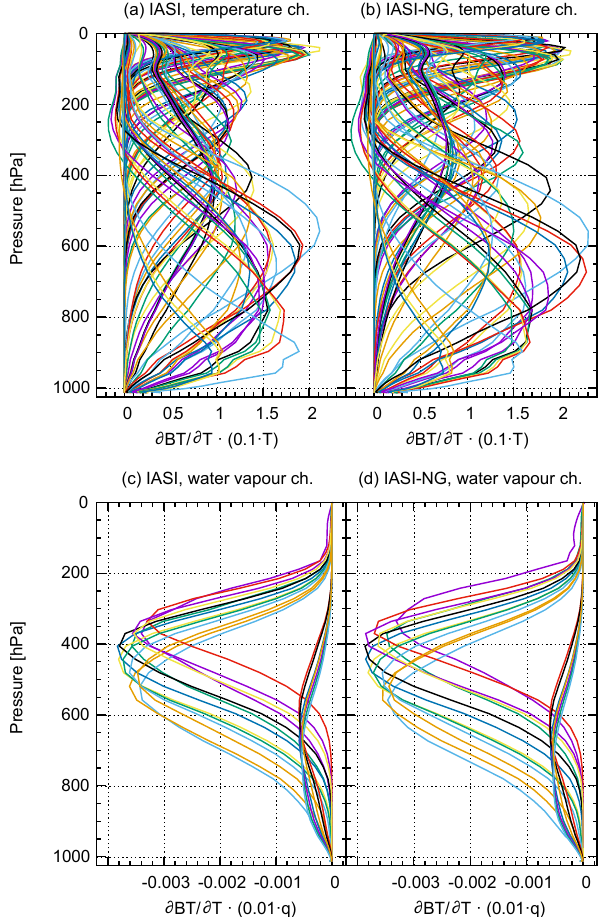
Figure 8. Temperature (a, b) and humidity (c, d) averaged Jaco- bians from the considered 1681 simulations computed for the 123 IASI (a, c) and IASI-NG (b, d) channels. The various colours corre- spond to the different channels to show their individual contribution.